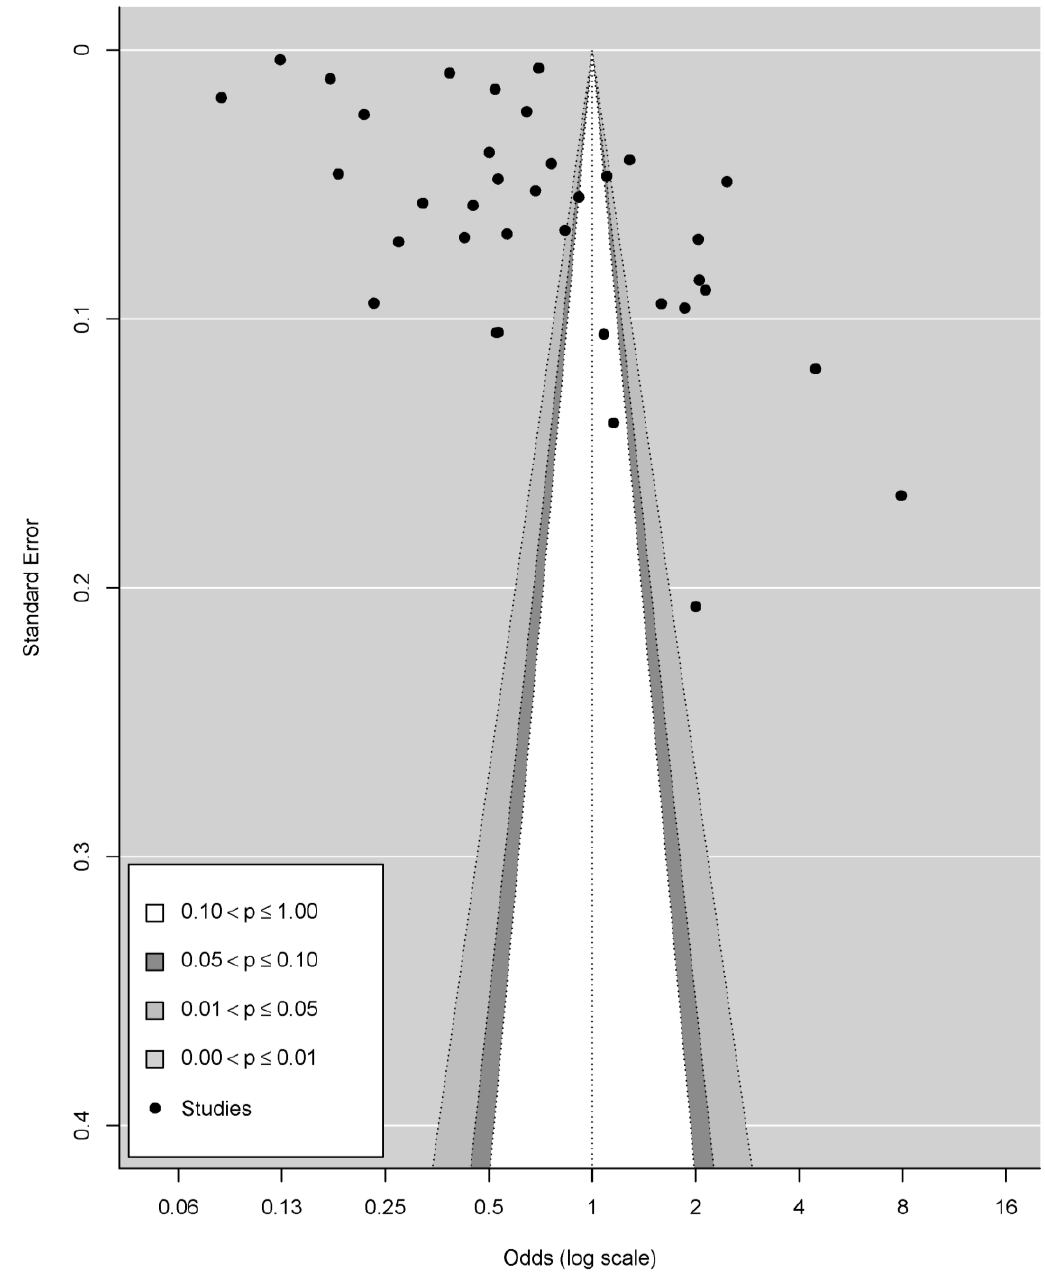
Figure 3. Funnel plot for publication bias.